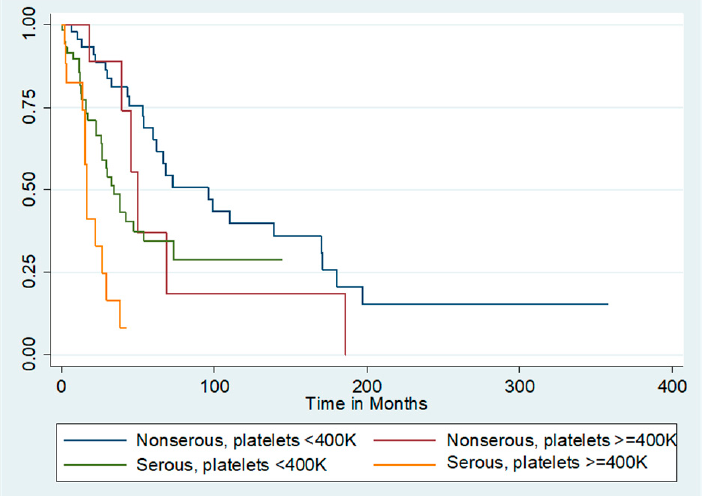
Figure 2. Unadjusted overall survival by thrombocytosis and histology. Median overall survival (OS) of all patients stratified by the thrombocytosis and serous histology. Median OS of non-serous tumors with thrombocytosis was 50 months and was 95.9 months for non-serous tumors without thrombocytosis. In contrast, serous tumors with thrombocytosis had a median OS of 16.4 months, and serous tumors without thrombocytosis had a median OS of 34.4 months ( p < 0.001).